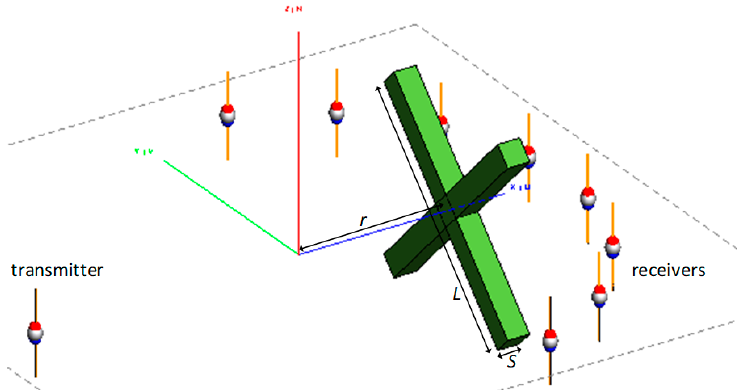
Figure 10. FEKO simulation model for the second 3D imaging example. The transmitter-receivers configuration, number of antennas, properties of the background and objects are similar to those in Figure 2. There is an X-shape object with square cross-section of size S = 4 mm and length of each arm of L = 56.25 mm. It is placed at radius of r = 36 mm with its arms rotated 45 z axes.